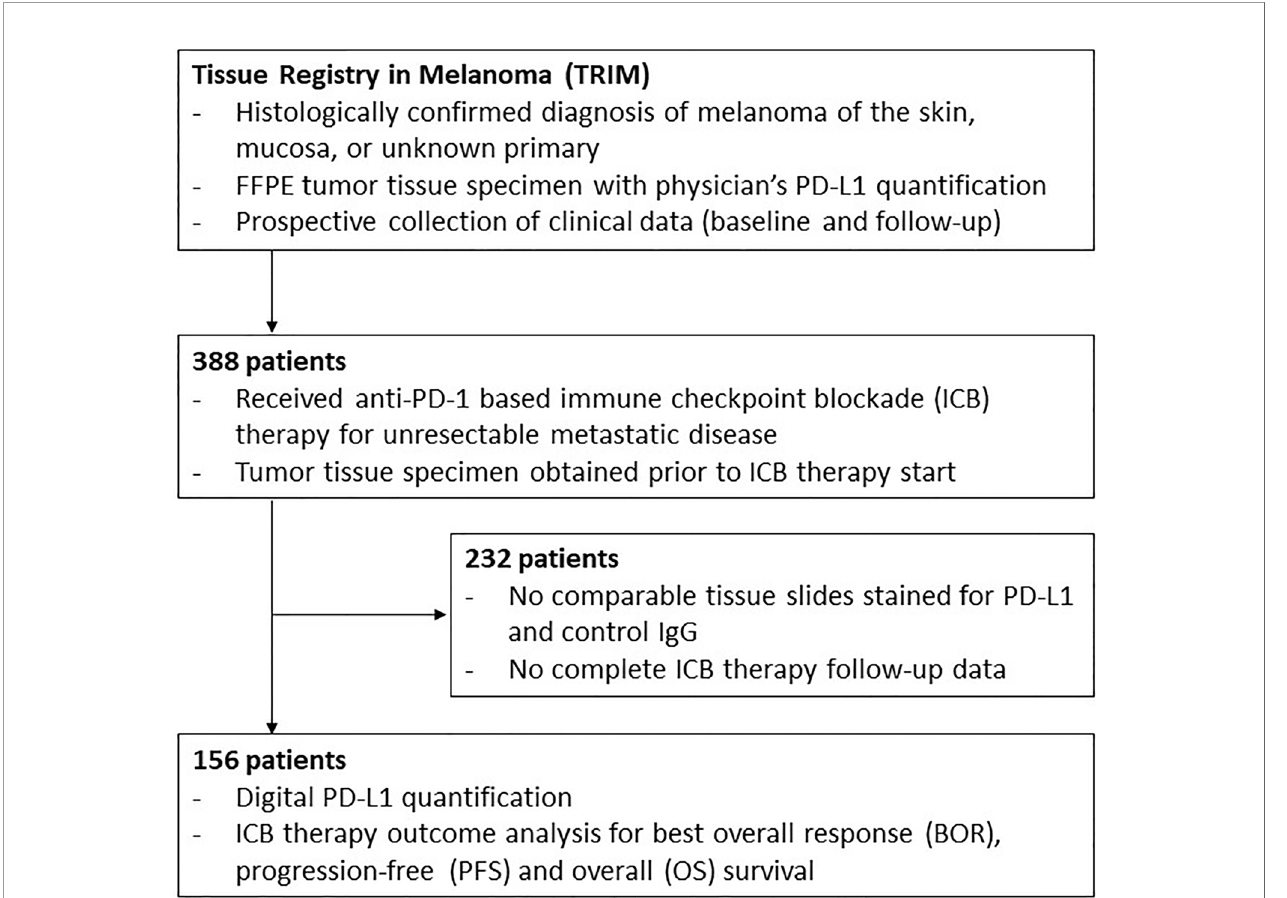
FIGURE 2 | Study fl ow. Schematic presentation of the study fl ow. P-values <0.05 are in